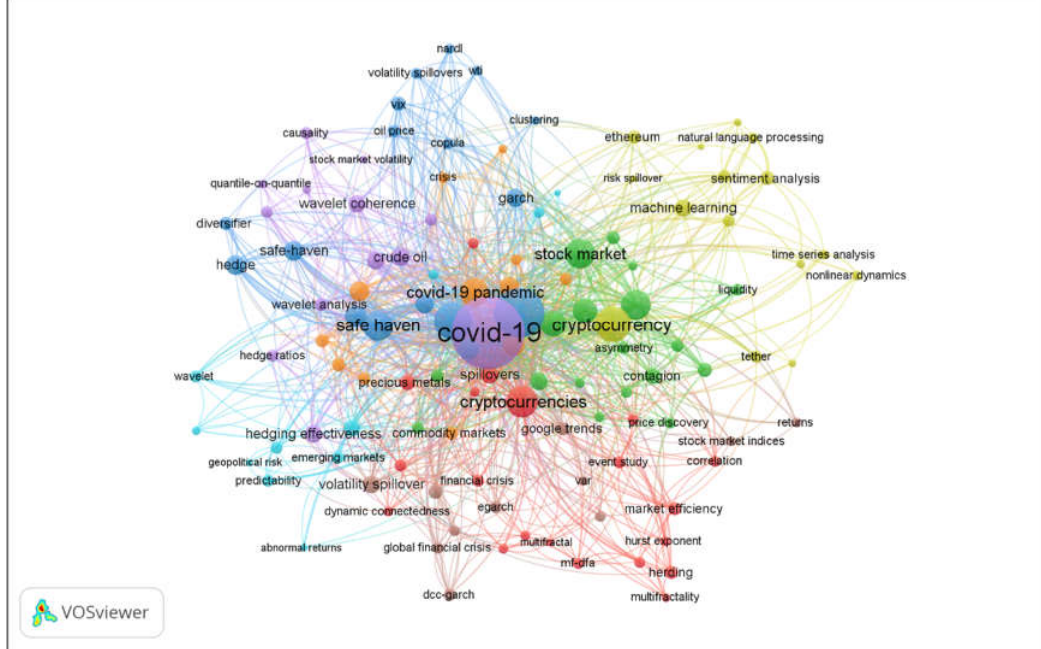
Figure 2. Cluster analysis based on the authors’ keywords. Source: VOSviewer/Scopus.